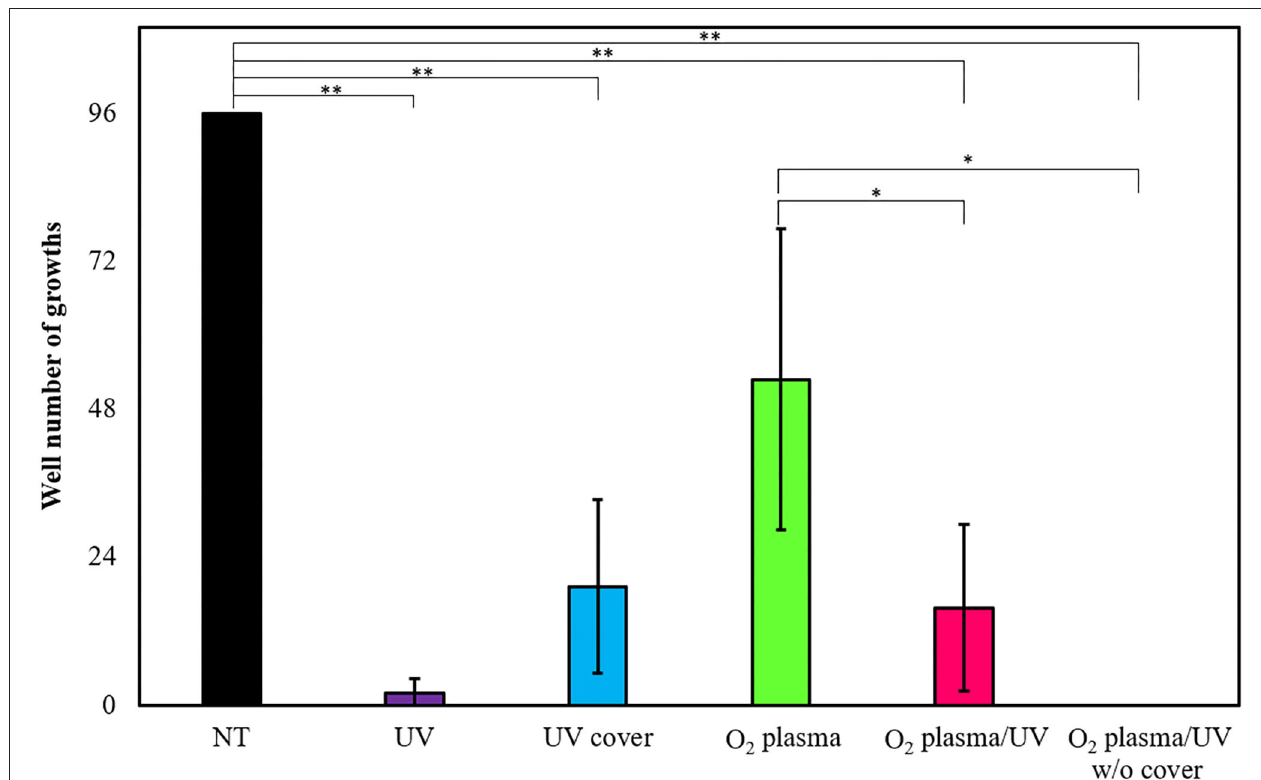
FIGURE 7 | Biofilm extinction by radical vapor reactor (RVR) treatment. Number of wells growing cells after treatment in UV (purple), UV cover (blue), O 2 plasma (green), O 2 plasma/UV (pink), and O 2 plasma/UV without cover mode. Formed E. coli biofilms on the 96-well plate were treated in each RVR mode for 10min, and then LB medium was added to all wells and incubated at 37 ◦ C for 16h. Wells which re-grew cells were counted. Non-treatment (NT) as a control is indicated at a black bar. Error bars indicate S.D. of at least three experiments. All data were analyzed using Tukey’s post-hoc test after one-way analysis of variance. Significant difference of two individual groups comparison connects with a line and indicates at asterisks (* P < 0.05, ** P < 0.01). The values obtained in these experiments are shown in Supplemental Table 4